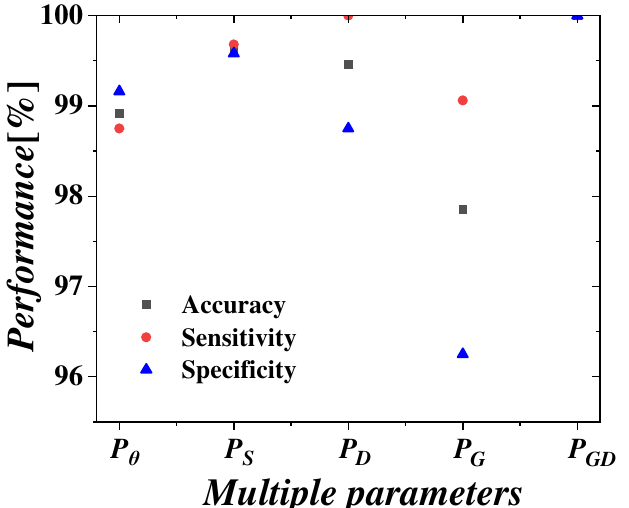
Figure 8. Training data performance of the STM-LSTM-based fall detection system, applying the multiple parameters.